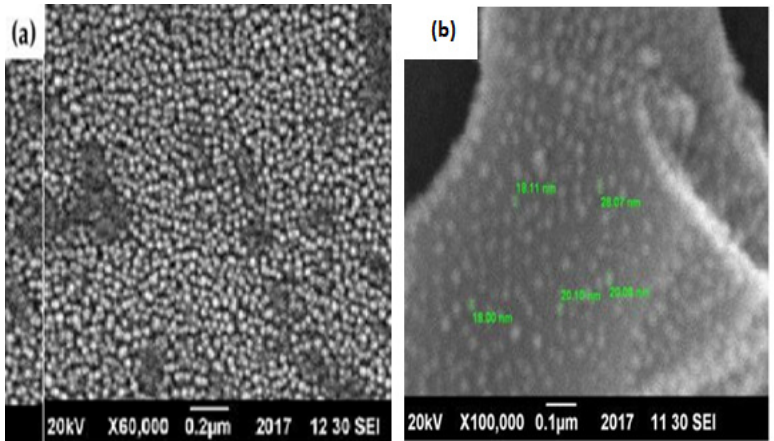
Figure 9. SEM of the catalyst with the ratio of Ni 4 Mo 0.2 MgO 1 . ( a ) Ni and Mo particles ( b ) Morphology of Ni/Mo/MgO catalyst particles with average size of 18 nm.